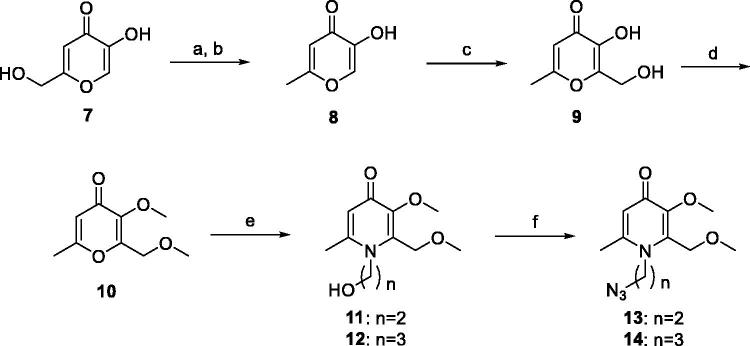
The synthetic route of intermediates 13 and 14. Reagents and conditions: (a) SOCl2, r.t., 4 h, 87%; (b) H2O, Zn, HCl, 70 °C, 72%; (c) 2.0 M NaOH, 37% HCHO, r.t., 12 h, 80%; (d) DMSO, CH3I, KOH, r.t., 10 h, 92%; (e) MeOH:H2O = 1:1, NH2(CH2)nOH, NaOH, reflux, 12 h, 78%–82%; (f) DMF, NaN3, Ph3P, CBr4, r.t., 1 h, 76%–78%.